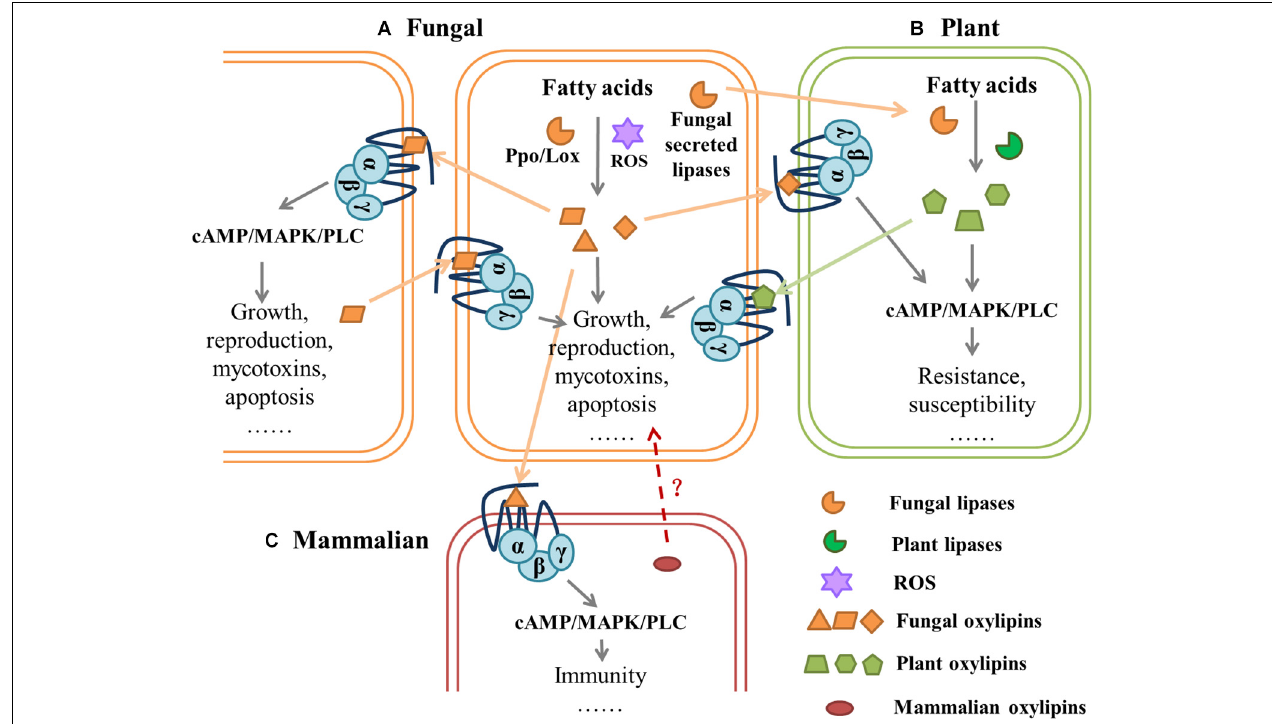
FIGURE 3 | Hypothetical model of mediated communication of G-protein-coupled receptors between fungi and their hosts.| (A) Fungal lipoxygenase (Lox) and psi-producing oxygenases (Ppo) or reactive oxygen species (ROS) can catalyze the oxidation of fatty acids (FAs) to oxylipins, which affect fungal behavior through downstream pathways. Different species of fungi can sense oxylipins secreted in vitro by GPCRs, which regulate cell growth, reproduction, mycotoxins, and apoptosis. (B) Fungal lipases are secreted into plant cells where fatty acid substrates are cleaved and processed by fungi- secreted lipoxygenases and/or plant lipoxygenases for oxylipin production. Plant-produced oxylipins are perceived and exploited by fungi to regulate GPCR-mediated behavior. (C) In mammalian cells, different signals from microbial-derived oxylipids, mediate inflammatory responses, and fungi can affect host physiology through GPCRs. It is also possible that mammalian oxylipins affect fungal activity. All fungal lipases and oxylipins are orange, all plant lipases and oxylipins are green, mammalian oxylipins are red. Dashed arrows with the question mark (?) indicates hypothetical interactions, and solid arrows represent proven interactions.